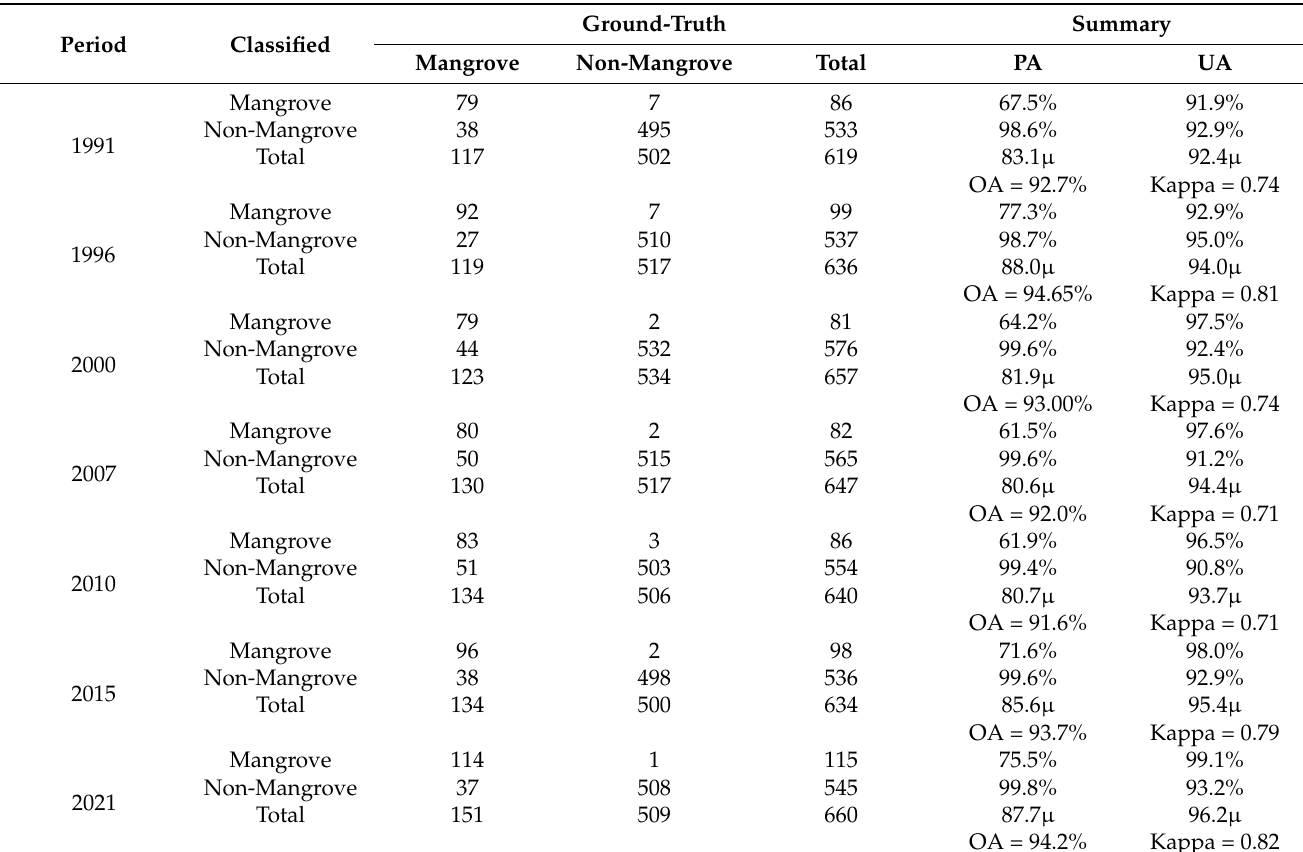
Table 2. Accuracy assessment of SVM classification results from mangrove forests in the Hainan Island during 1991–2021, where µ depicts the average values.